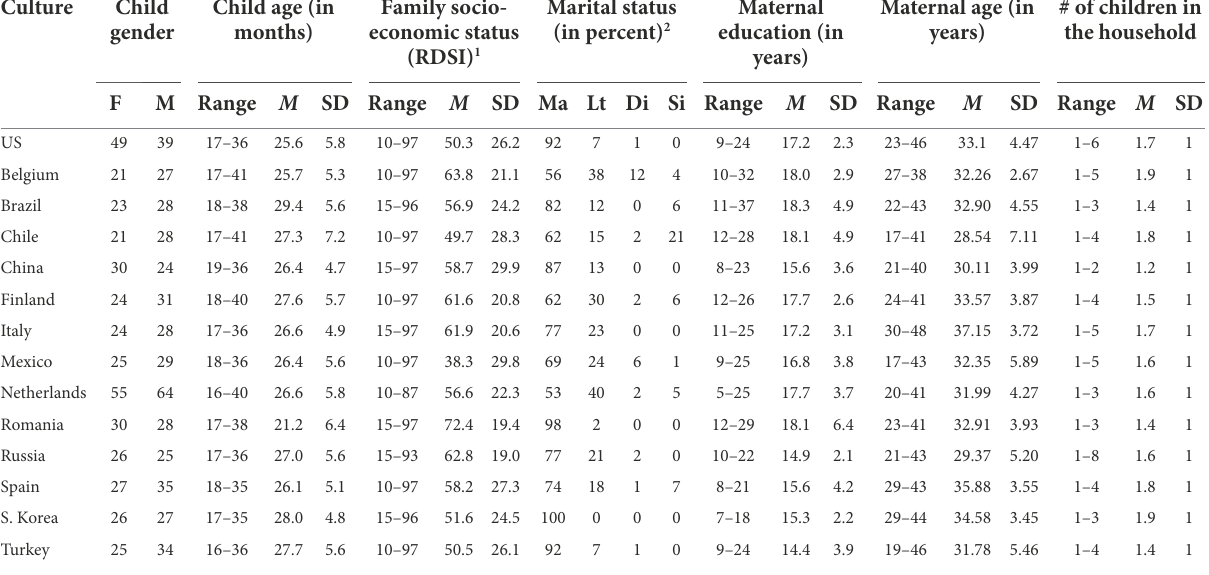
TABLE 1 Sample demographics by